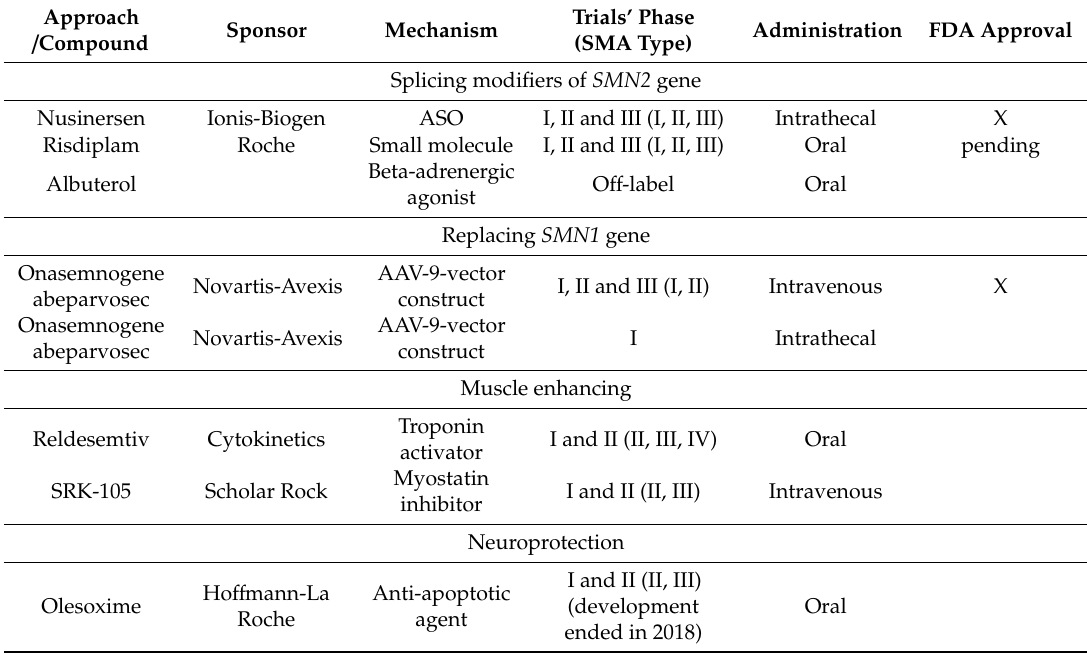
Table 1. Main clinical developments in spinal muscular atrophy